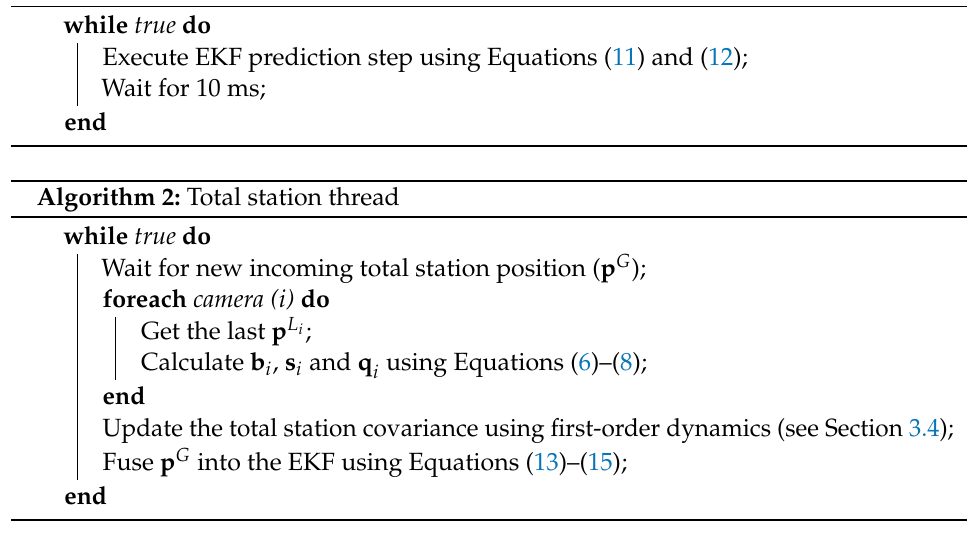
Algorithm 1: EKF prediction thread.